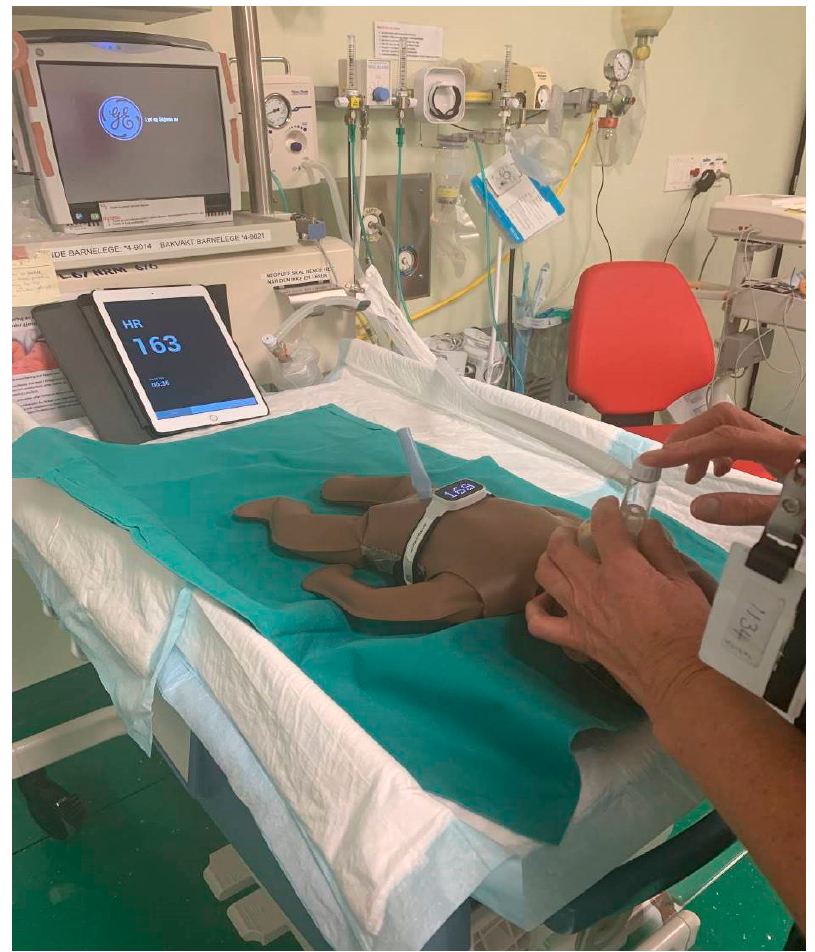
Figure 1. Study participant ventilates NeoNatalie Live with a NeoPuff T-piece resuscitator. The heart rate is clearly visible on both the NeoBeat sensor applied to the manikin and the tablet-device with the training application open.